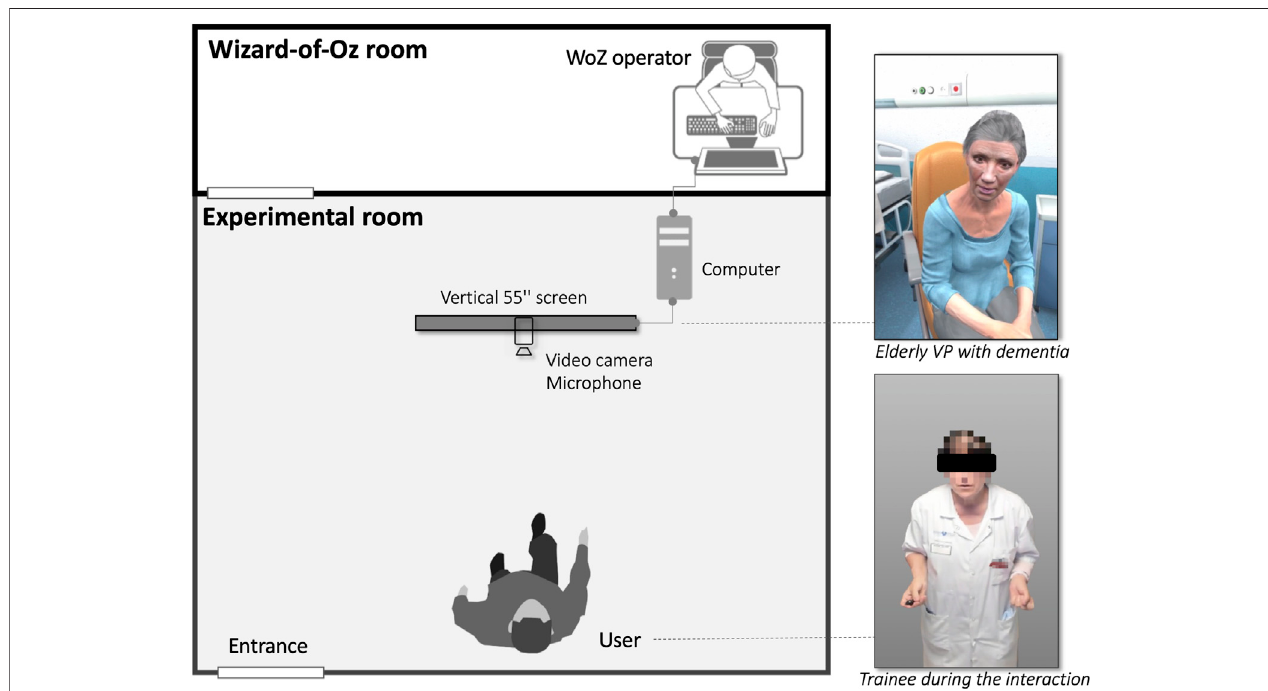
FIGURE 3 | Overall architecture of the VirtuAlz platform. Here a user (i.e., clinician) is instructed to interact in a face-to-face clinical encounter with Ms. Dupont, an elderly virtual patient (VP) with Alzheimer ’ s disease symptoms. The 10-min interaction concerns taking medication and the VP exhibits behaviors such as agitation, aggression, apathy, or refusal of medication, and that the clinician must address (e.g., stimulate or pacify the patient) in order to persuade them to take their medication. The interface with the VP, including the hospital room, is displayed on a large screen (55 ′ ). The VP is controlled by a Wizard-of-Oz (WoZ) operator and equipped to record the user ’ s non-verbal behaviors (i.e., through a video camera and microphone) to modulate the evolution of the interaction.